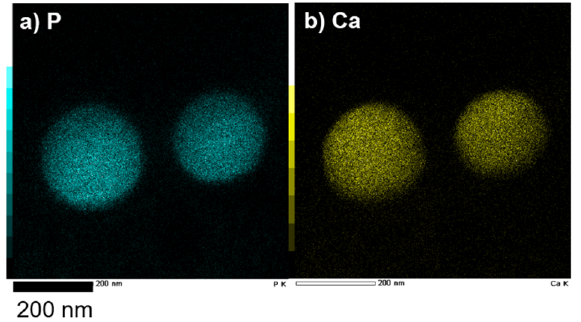
Figure 4. EDX mapping images of ( a ) phosphorous and ( b ) calcium for CaCO 3 -coated vesicles after 18-day mineralization. “P” and “Ca” indicate phosphorus of azolectin and calcium of CaCO 3 , respectively.